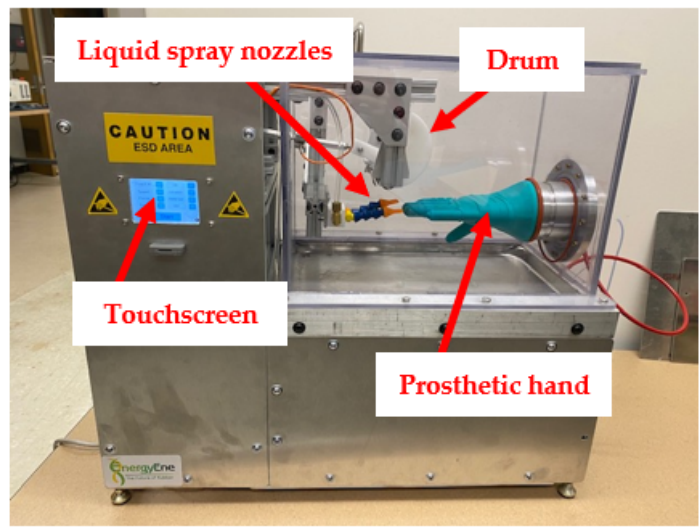
Figure 13. Final assembly of the new glove testing device.